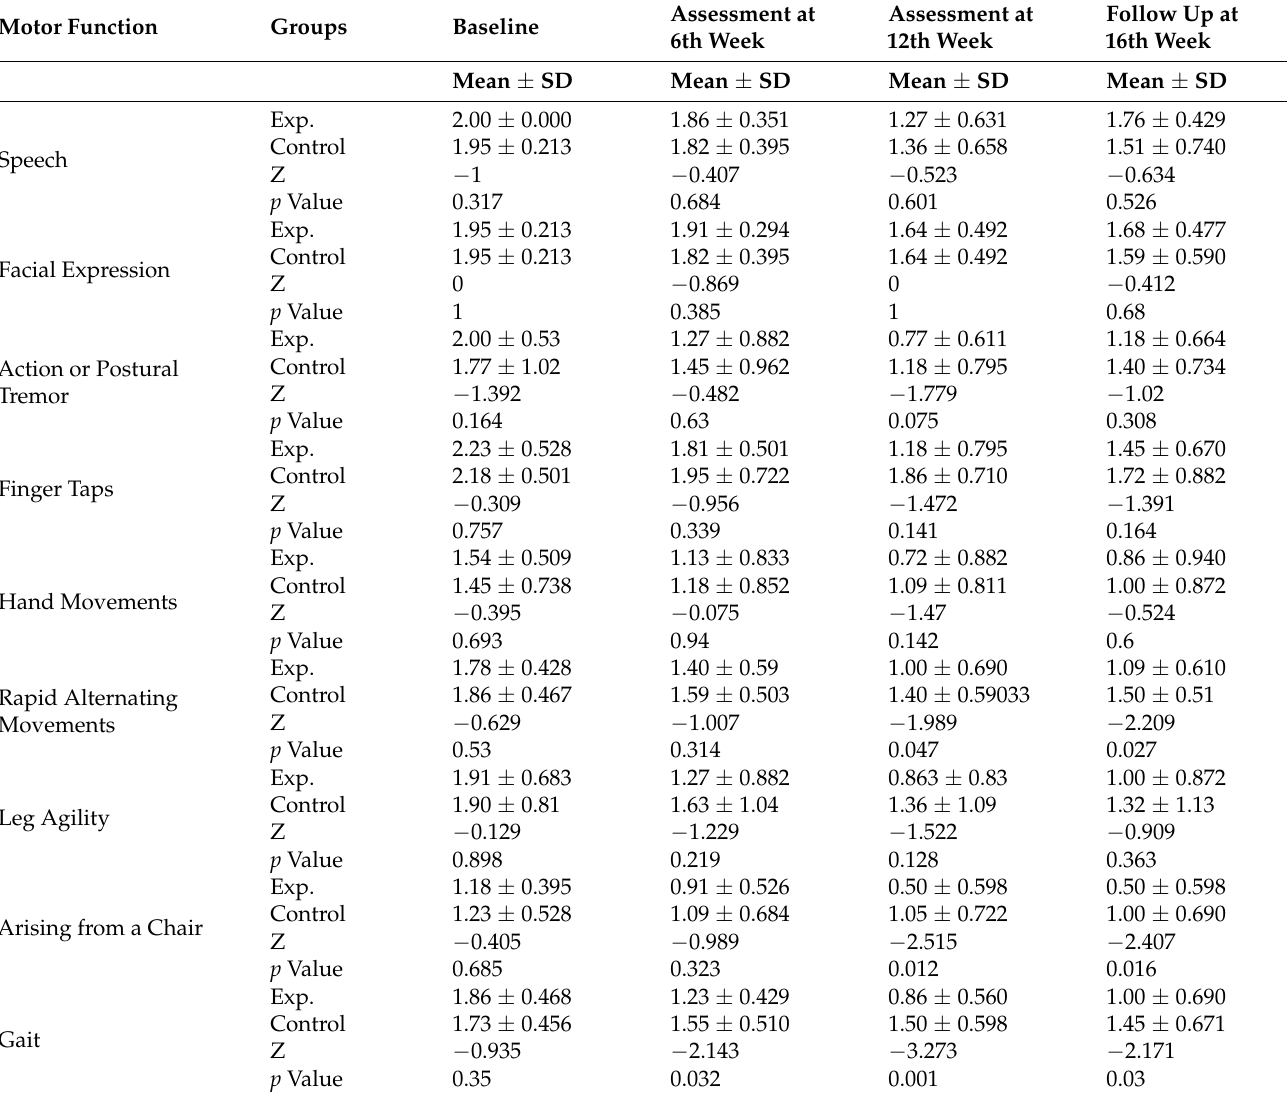
Table 2. Comparison of experimental and control group regarding the mean scores of UPDRS part